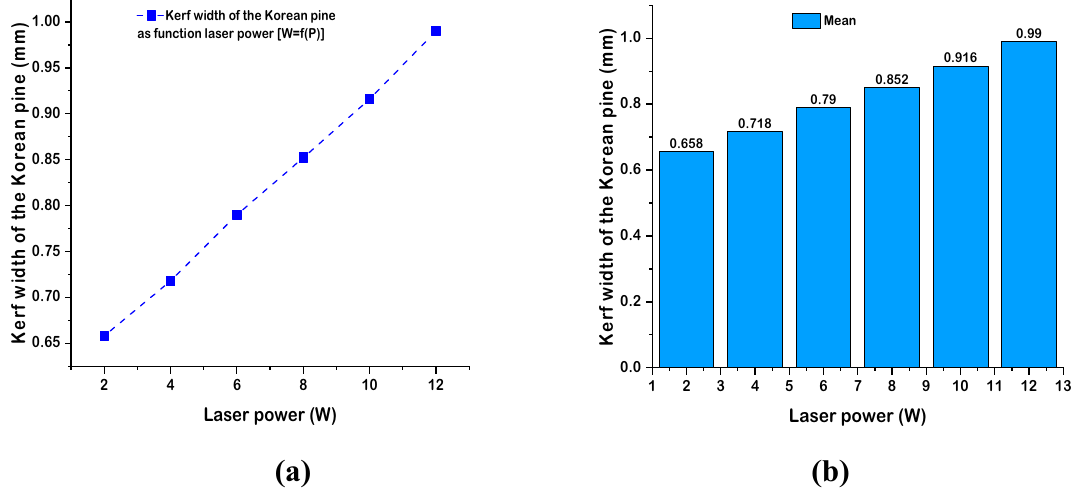
Fig. 10 Pinus Koraiensis kerf width variation as a function of laser power [ W = f (P )] a Kerf width of Korean pine under different laser power, b Histogram of kerf width versus laser power